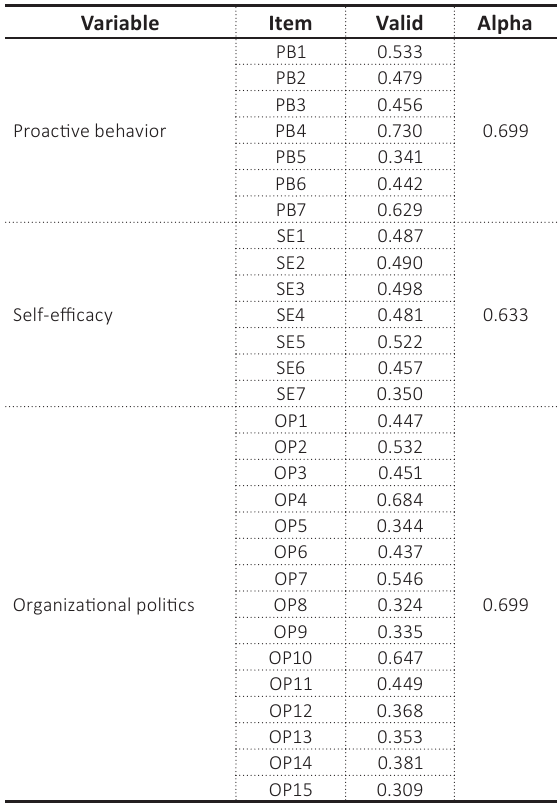
Table 2. Results of Moderated Regression Analysis